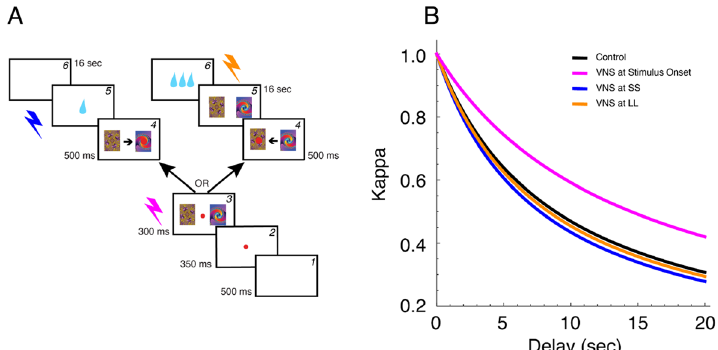
Fig. 4 Effect of VNS on choice. A Schematic representation of the inter-temporal reward choice task. ( 1 ) The subject was required to fixate on a red dot presented in the middle of the screen, straight ahead for 350 ms, at which point ( 2 ) two fractal images representing the SS and LL were displayed to the left and right of the fixation point while the subject maintained fixation. ( 3 ) Upon offset of the fixation point, the signal to respond, the subject was expected to make a saccadic eye movement to one of the two fractal images, indicating his choice. ( 4 ) When the eye-tracker detected the subject’s eyes within the acceptance window of one of the images, a large red dot was overlaid on the fractal, indicating to the subject his choice. ( 5 ) In this example, the subject chose the SS (left image), in which case the reward was delivered immediately and a 16 s wait would precede the start of the next trial. Conversely, had the subject chosen the LL (right image), a delay of 16 s would have preceded the delivery of the reward and the onset of the next trial would have followed shortly after. Both images remained on the screen for the duration of the delay period. B Discounting values (Kappa) for control and three VNS conditions: VNS paired with stimulus onset, with SS and with LL. In this single session, the value of Kappa was smaller than in the other three conditions, indicating that the NHP was more patient in evaluating his